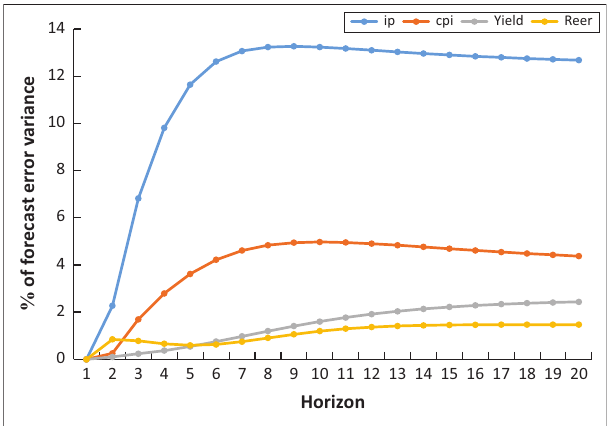
FIGURE 3: Contribution of economic policy uncertainty index to forecast error